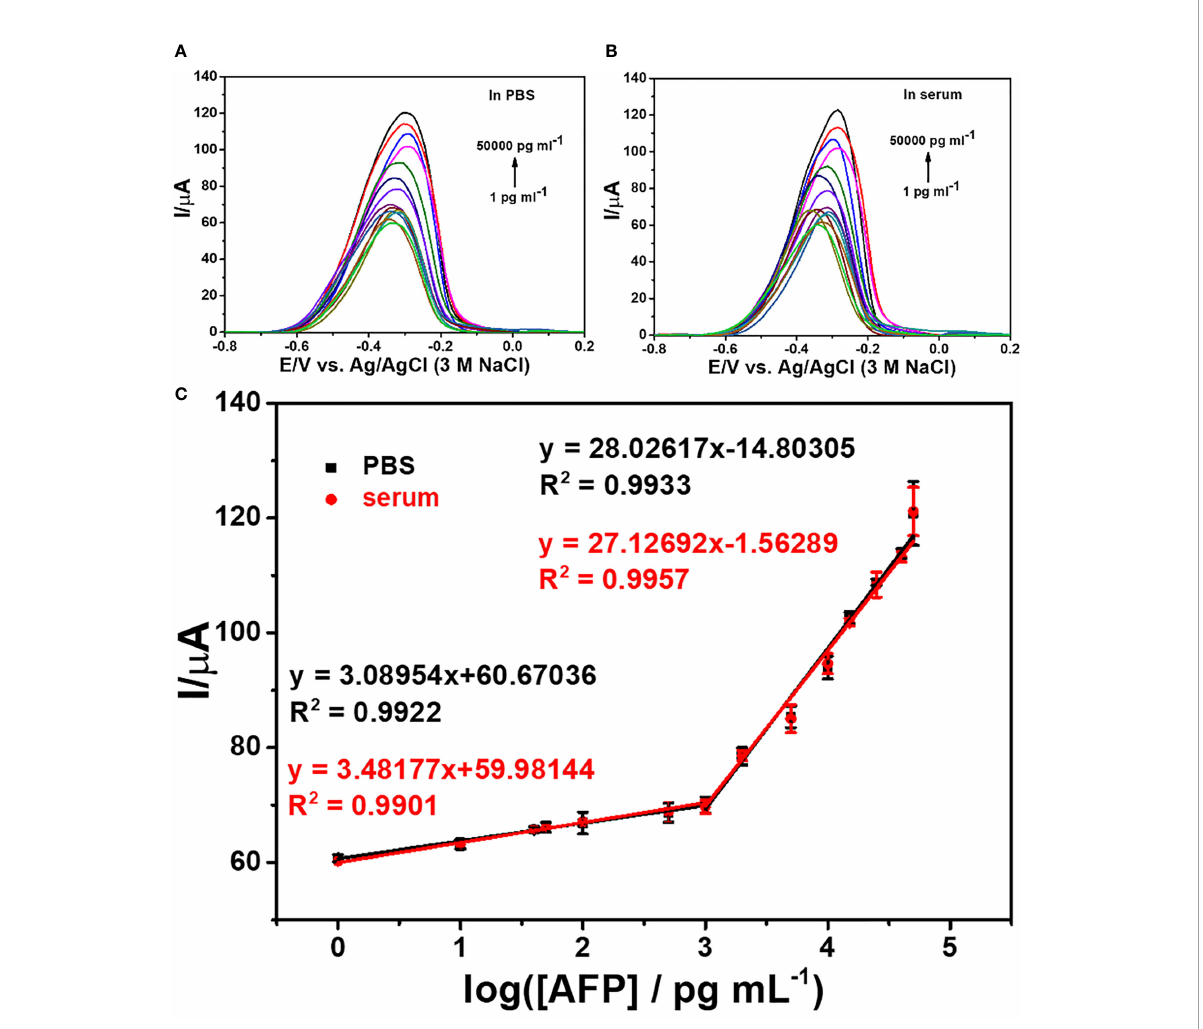
FIGURE 6 DPV responses of the immunosensors after incubation with AFP in PBS (A) and 50-fold diluted human serum (B) at different concentrations and (C) logarithmic calibration curves of the two matrix